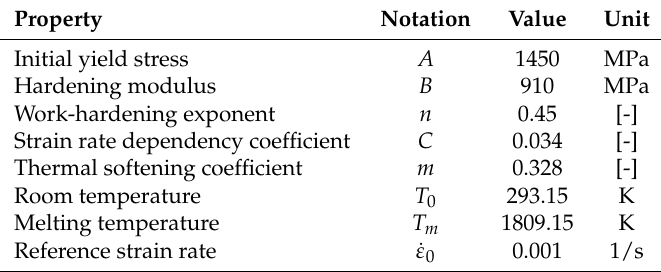
Table 4. Johnson-Cook model parameters of AISI 4140 [21].